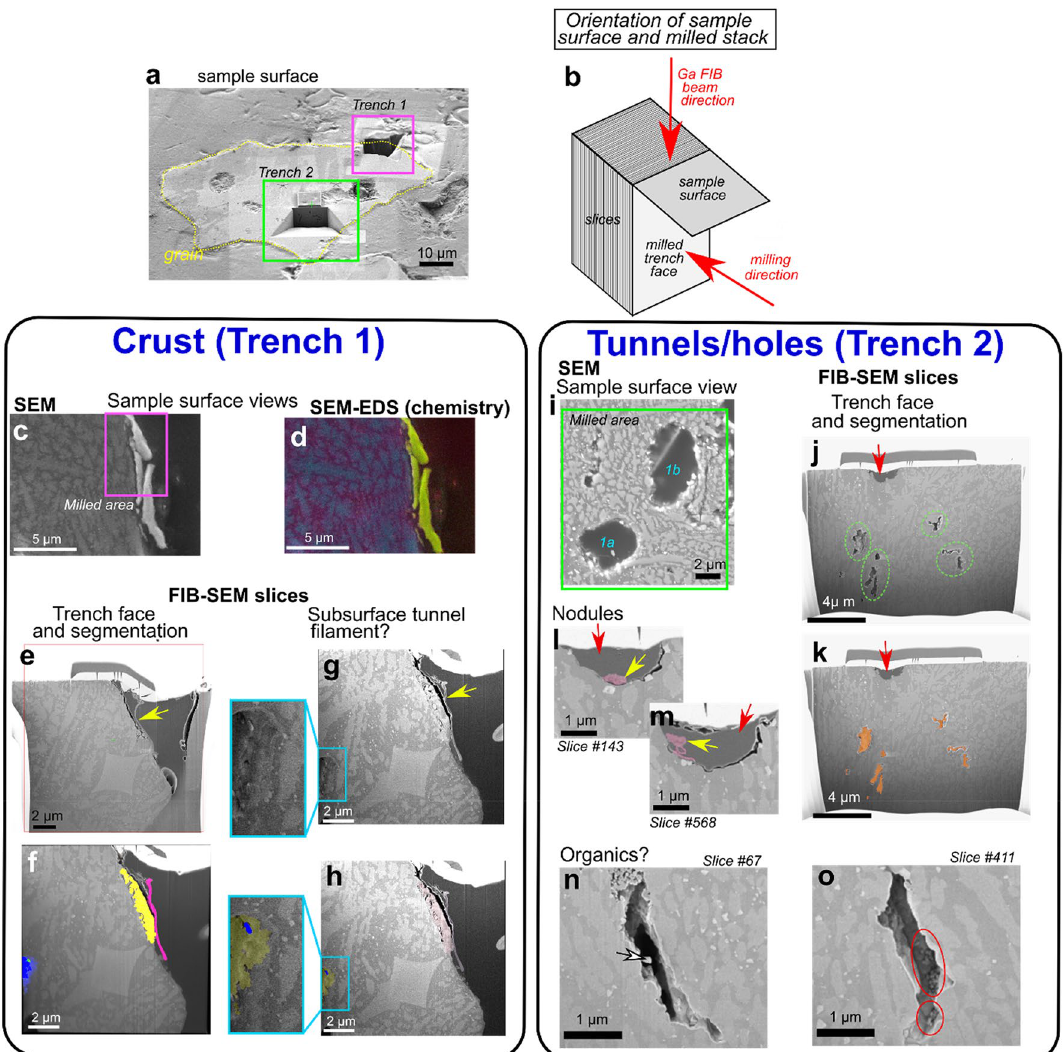
Figure 5. Location of FIB-SEM trenches and tomographic volumes. (a) Exposed grain from targeted XRM slice and surface material removal. Blue boxes highlight the milled trenches (1 and 2) (b) Schematic explaining the orientations associated with trench milling and sample surface. (c-h) Trench 1 (crust). Sample surface view (c) , accompanying chemical map (key the same as for Fig. 4) (d), and view of the trench face after Atlas 5(3D) sample preparation and fine polish (e–h); yellow arrow indicates filamentous structure on crust. (f, h) Trench face highlighting false colour segmented components; yellow = crust, pink = filamentous portion of crust, blue = interior tunnel, green = (probable organic) filament within tunnel. (g) Final post-mill trench face highlighting subsurface tunnel containing a filament, with segmented version (h). (i-o) Trench 2 (tunnels/ holes). (i) Sample surface view showing the milled area over hole types 1a,b from Fig. 4. (j, k) Trench face highlighting subsurface tunnels that are unobservable from XRM imaging (green circles) and surface holes (red arrow). Segmented subsurface tunnels shown in (k). (l, m) Close up view of surface holes (red arrows) from two different slices through the volume highlighting segmented Fe nodules (yellow arrows). (n, o) Two examples of slices of subsurface tunnels, both exhibiting inhabiting potential organic filamentous (white arrow) and coccoid structures (red